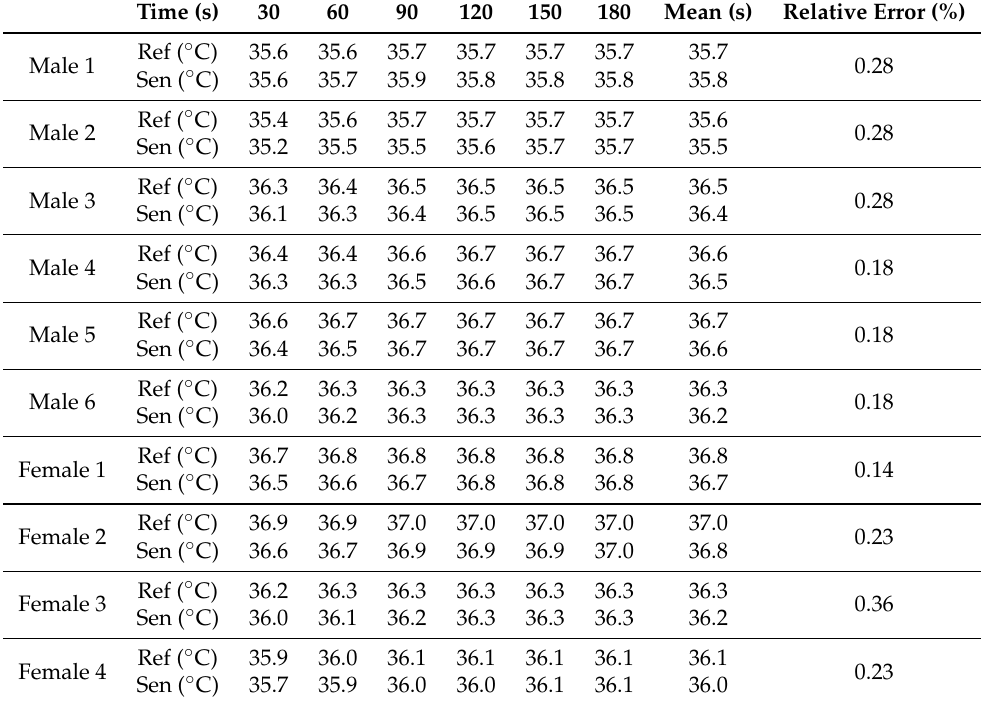
Table 4. Summary of the experimental results of body temperature